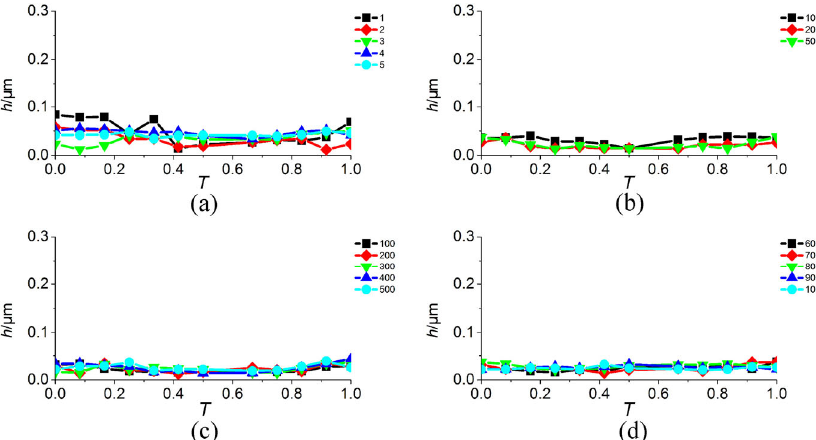
Fig. 19 Variation of minimum film thickness in some typical working periods ( v max =0.01 m/s, w =50 N, T =0.3 s, L =0.75 mm).